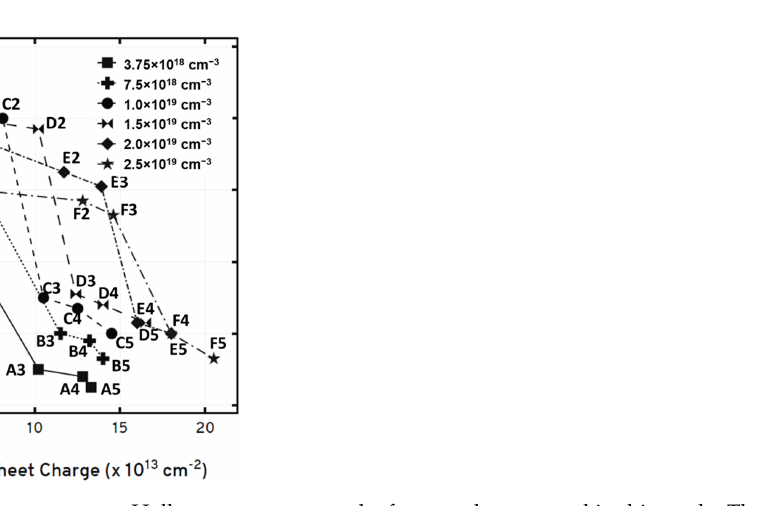
Figure 5. Room-temperature Hall measurement results for samples reported in this study. The figure shows the measured mobility as a function of the measured total sheet charge concentration for the various Mg doping levels used. Table 1. Samples presented in the work labeled A-1 through F-5, with the letter referring to the Mg doping series and the number referring to the AlN thickness series for each doping series. This table also indicates whether the acceptor trap ionization is at interface PPI-1 (AlGaN/AlN interface) or interface PPI-2 (GaN/AlGaN interface) or both interfaces. The table also mentions whether there is an effect on the measured mobility ( Δ > 2.0 cm 2 /Vs) by the ionization of these traps. When traps at both interfaces are unionized, then “-“ is mentioned to indicate that the acceptor-like traps are unionized and therefore have no effect on the mobility (in that case, mobility may be affected slightly by the increase in charge, as indicated in Figure 5). Traps at PPI-1 Traps at PPI-2 Effect of Traps (Defined in Figure 6) (Defined in Figure 6) on